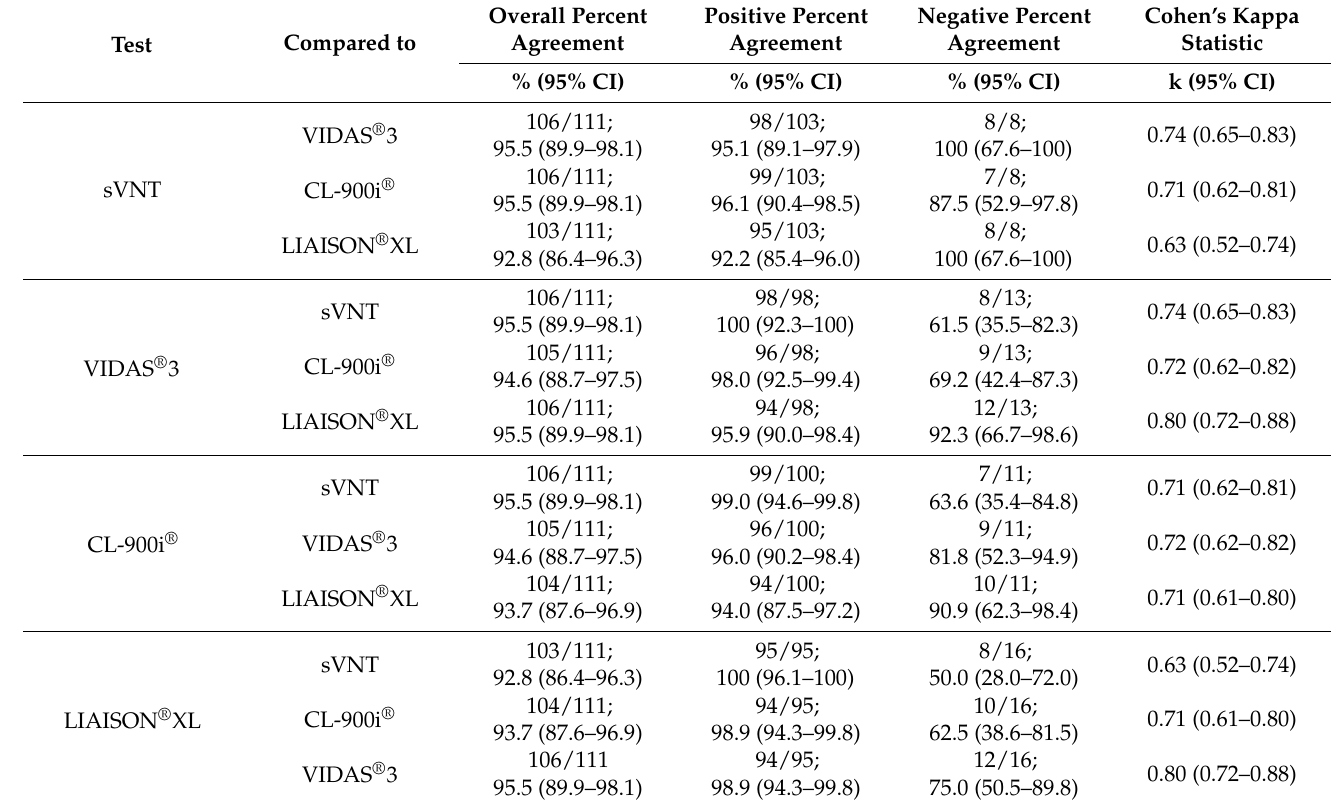
Figure 4. Sensitivity for each assay on samples collected ≥ 21 days post symptom onset in patients with SARS-CoV-2 RT-PCR-confirmed infection using the sVNT as a reference test. Data are pre- sented for 111 RT-PCR confirmed SARS-CoV-2 positive samples categorized as: overall ( n = 111), symptomatic ( n = 56); and asymptomatic ( n = 51); run on each automated assay; VIDAS ® 3, CL-900i ® SARS-CoV-2, and LIAISON ® XL. Chi-square test was used to detect the presence of a statistically significant difference in the sensitivity of each assay between the symptomatic and asymptomatic samples. * p < 0.05, ** p < 0.001. Table 4. Concordance assessment between the sVNT, VIDAS ® 3, CL-900i ® , and LIAISON ® XL